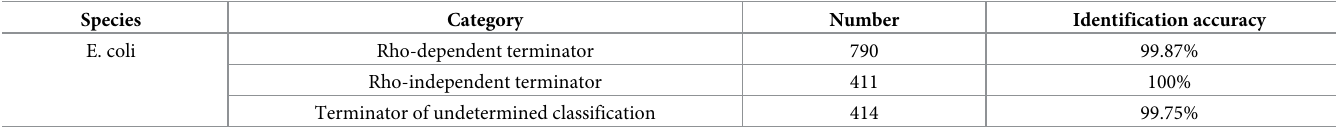
Table 8. Sequence details and recognition